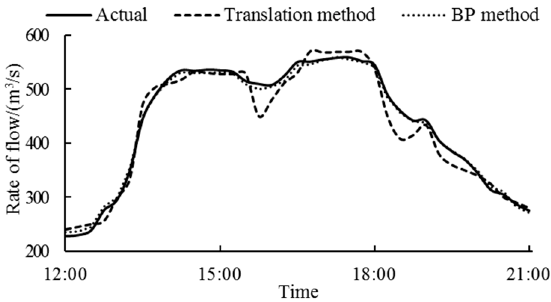
Table 1. Correlation coefficients between input layer data and the output layer.